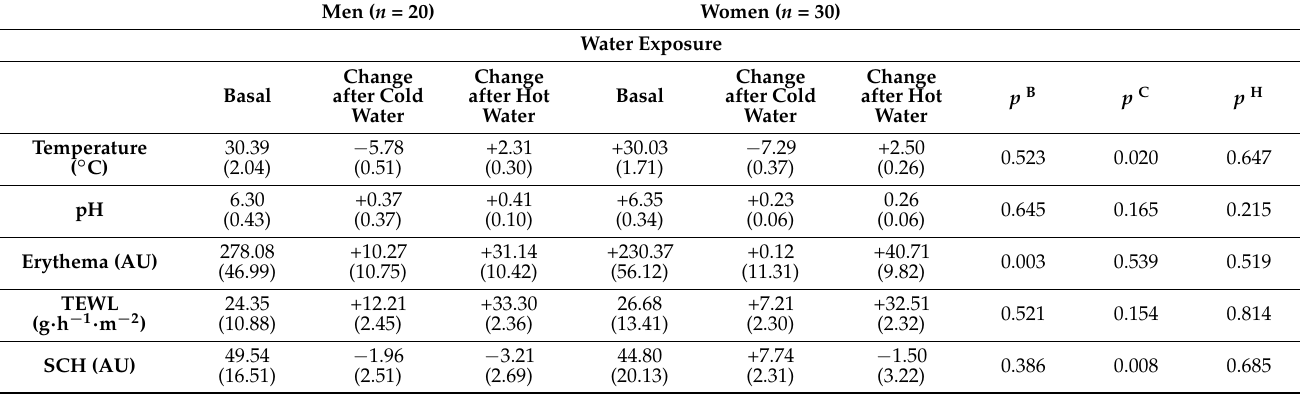
Table 2. Changes in skin barrier function after hot and cold and water exposure, stratified by sex.